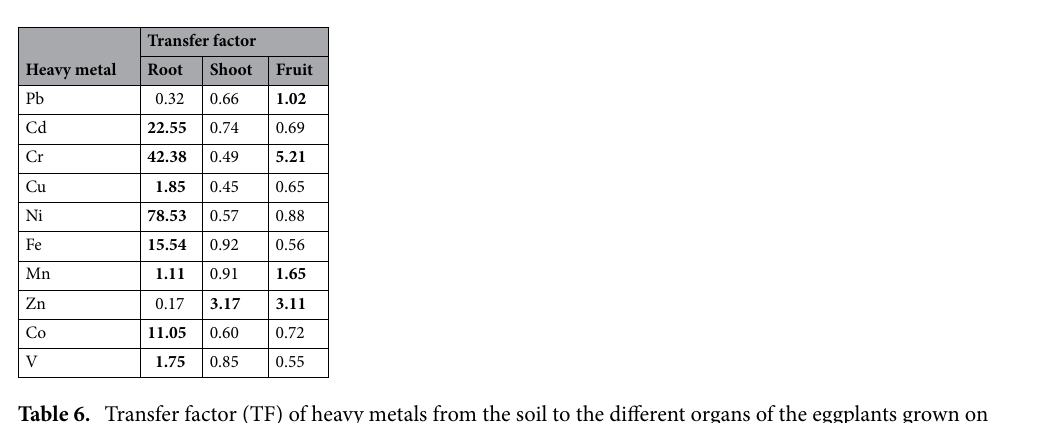
Table 6. Transfer factor (TF) of heavy metals from the soil to the different organs of the eggplants grown on uncontaminated and contaminated farms. Values > 1 are bold.